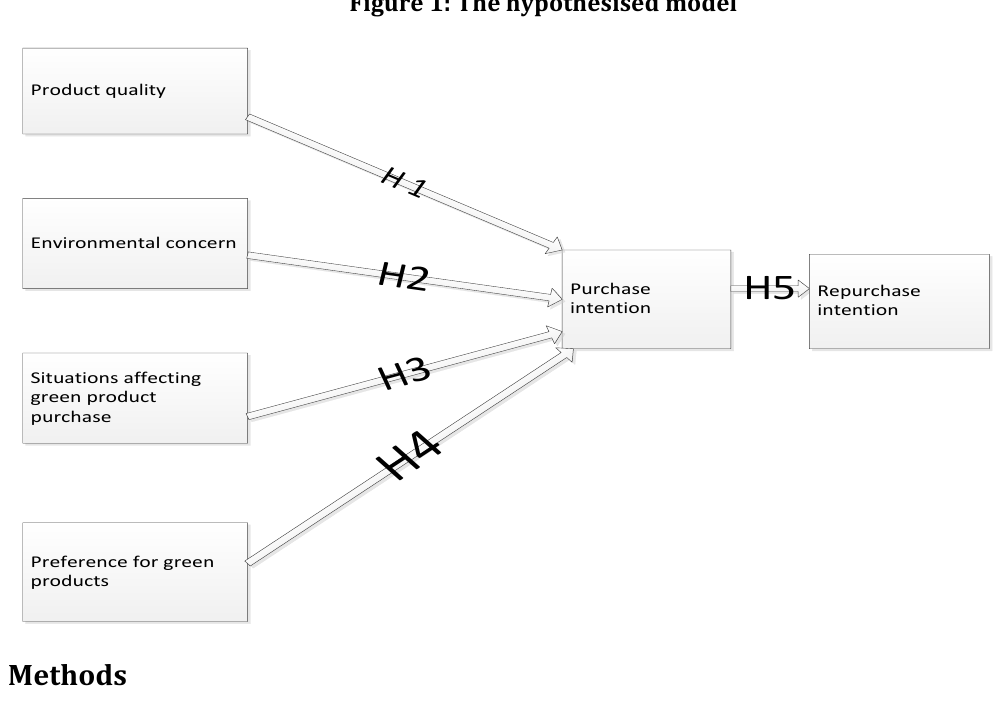
Figure 1: The hypothesised